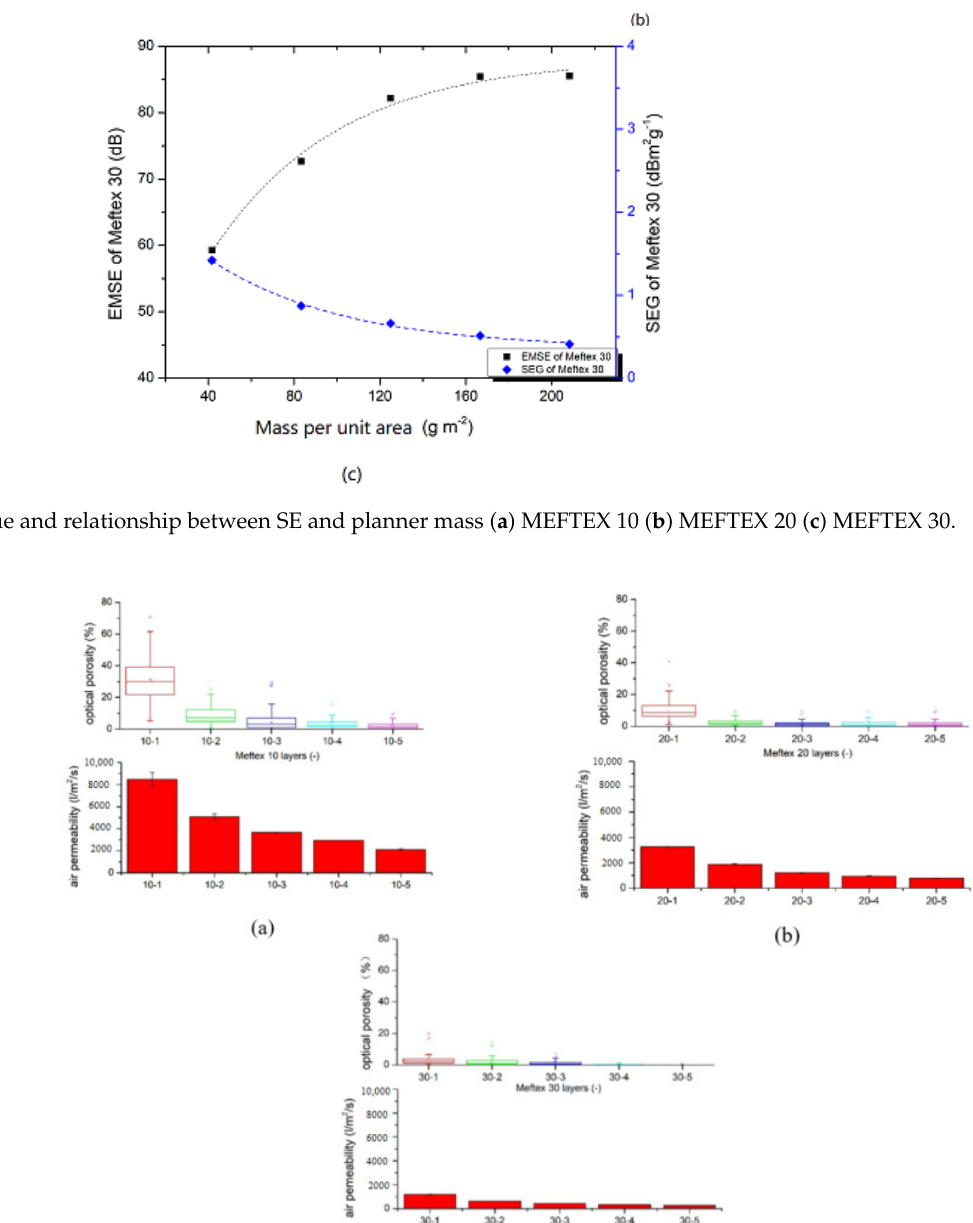
Figure 9. Optical porosity presented by porous distribution boxplot and air permeability influenced by increasing of layers ( a ) MEFTEX 10 ( b ) MEFTEX 20 ( c ) MEFTEX